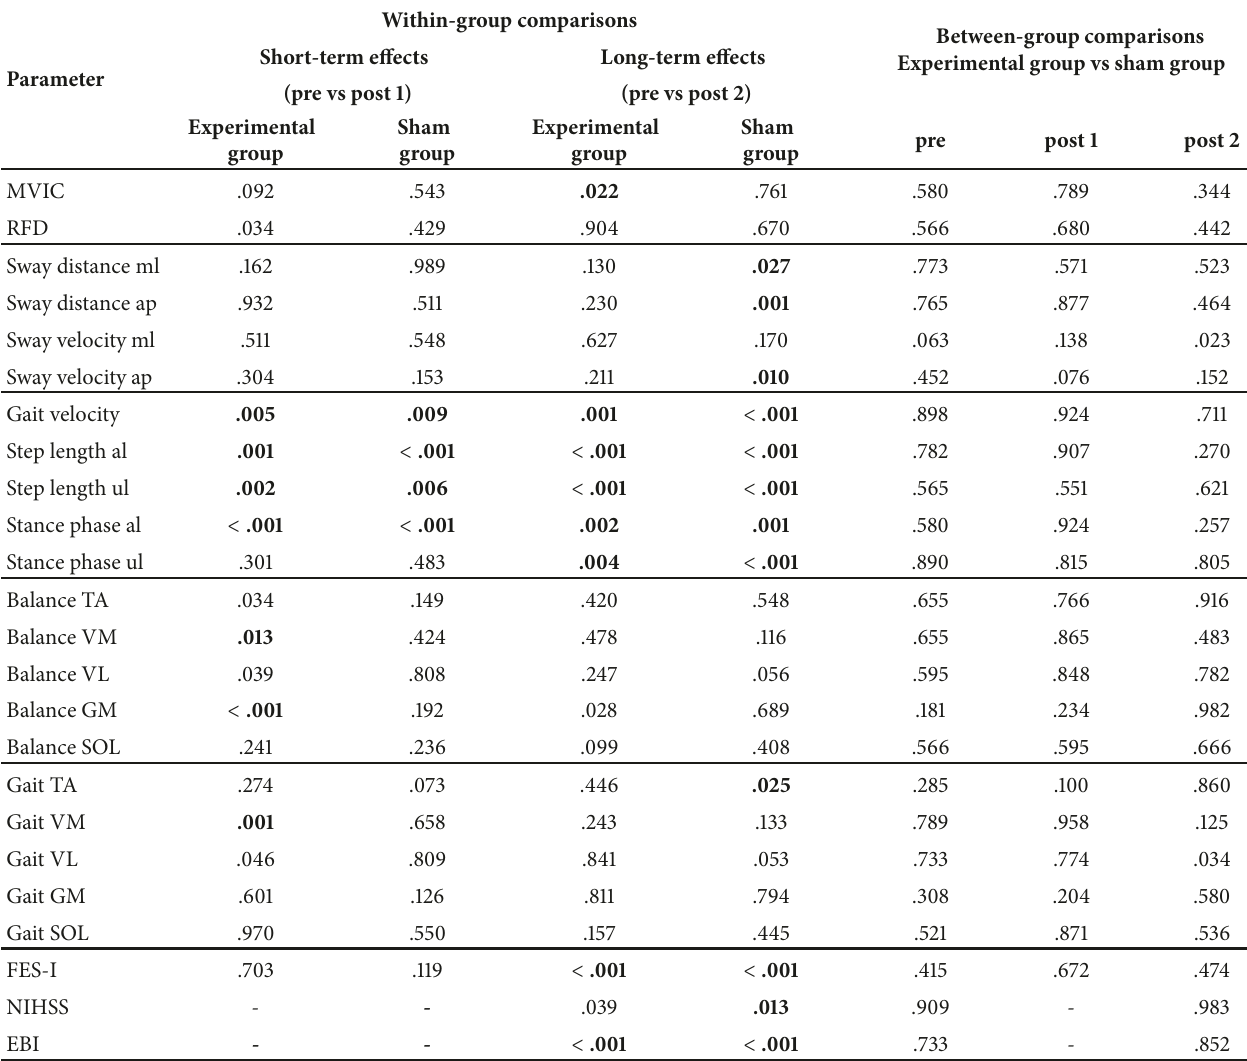
Table 3: Results for the within- and between-group comparisons (Wilcoxon signed-rank and Mann–Whitney U test, respectively) of the primary and secondary outcome parameters. Statistical significance was accepted at the p ≤ 0.025 level (Bonferroni